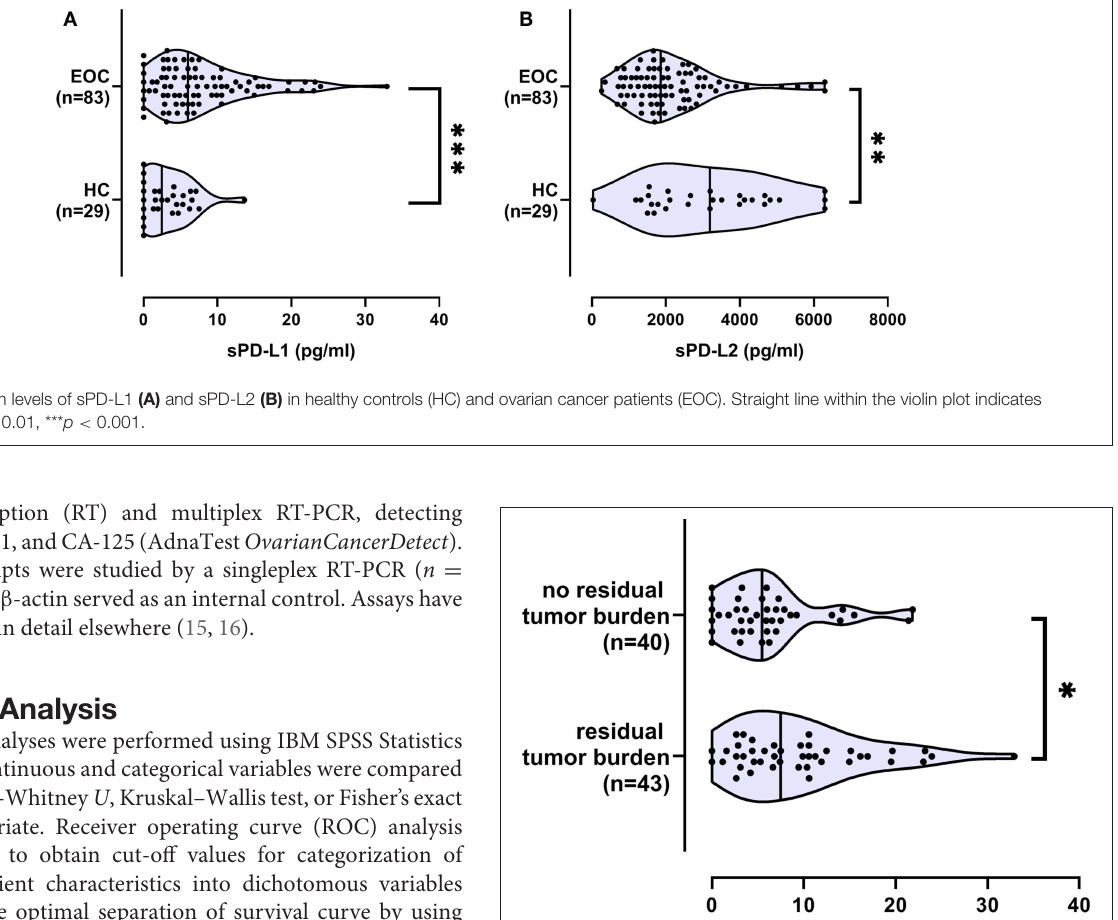
FIGURE 2 | Increased sPD-L1 serum levels in EOC patients with residual tumor burden. Straight line within the violin plot indicates the median. * p <